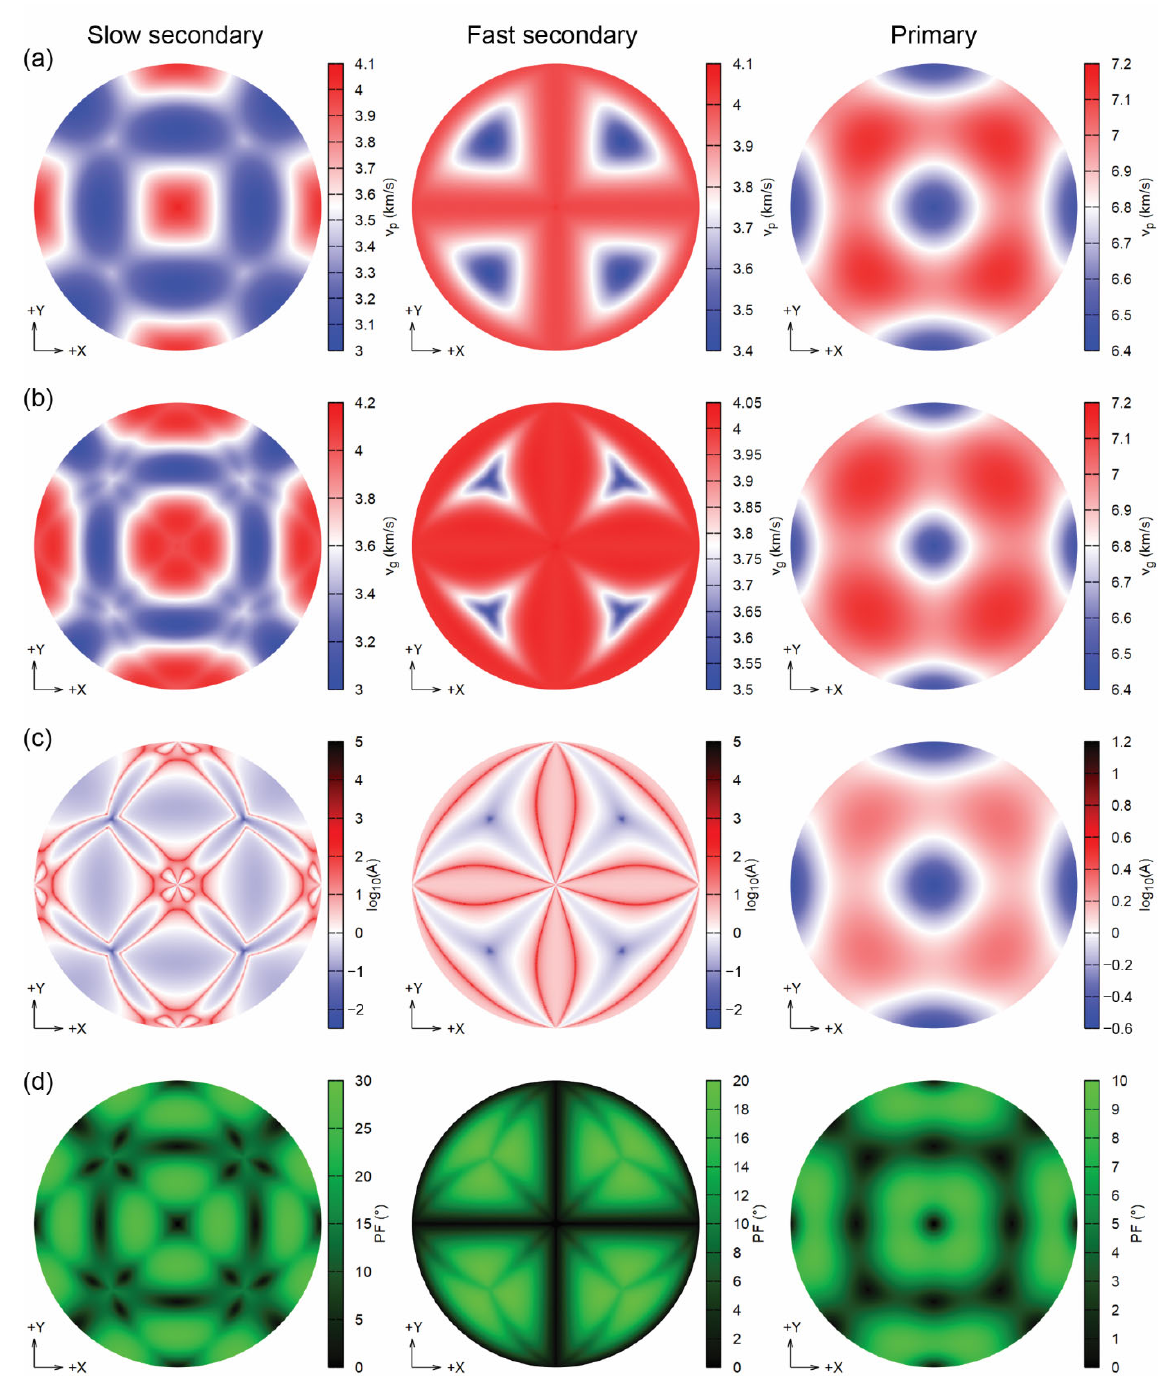
Figure 5. Analysis of the seismic wave velocities (Lambert equal-area upper hemisphere projections) of sodalite at 0 GPa, showing ( a ) the phase velocities v P (km/s), ( b ) the group velocities v P (km/s), ( c ) the enhancement factor A and ( d ) the power flow angle (PF, °).